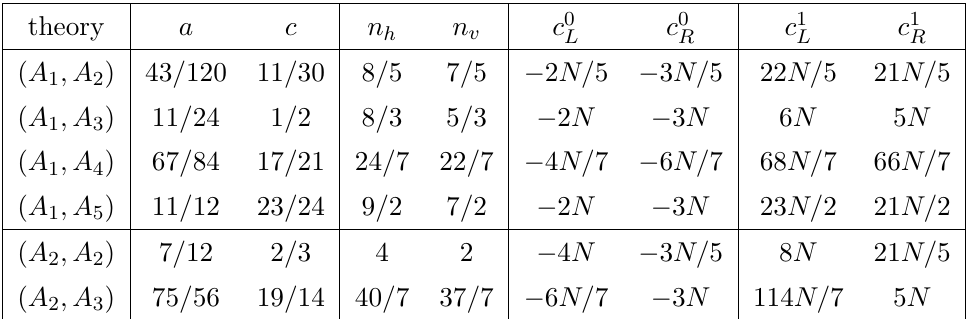
; c 0 ) = (2( n h (cid:0) n v ) ; 3( n h (cid:0) L R